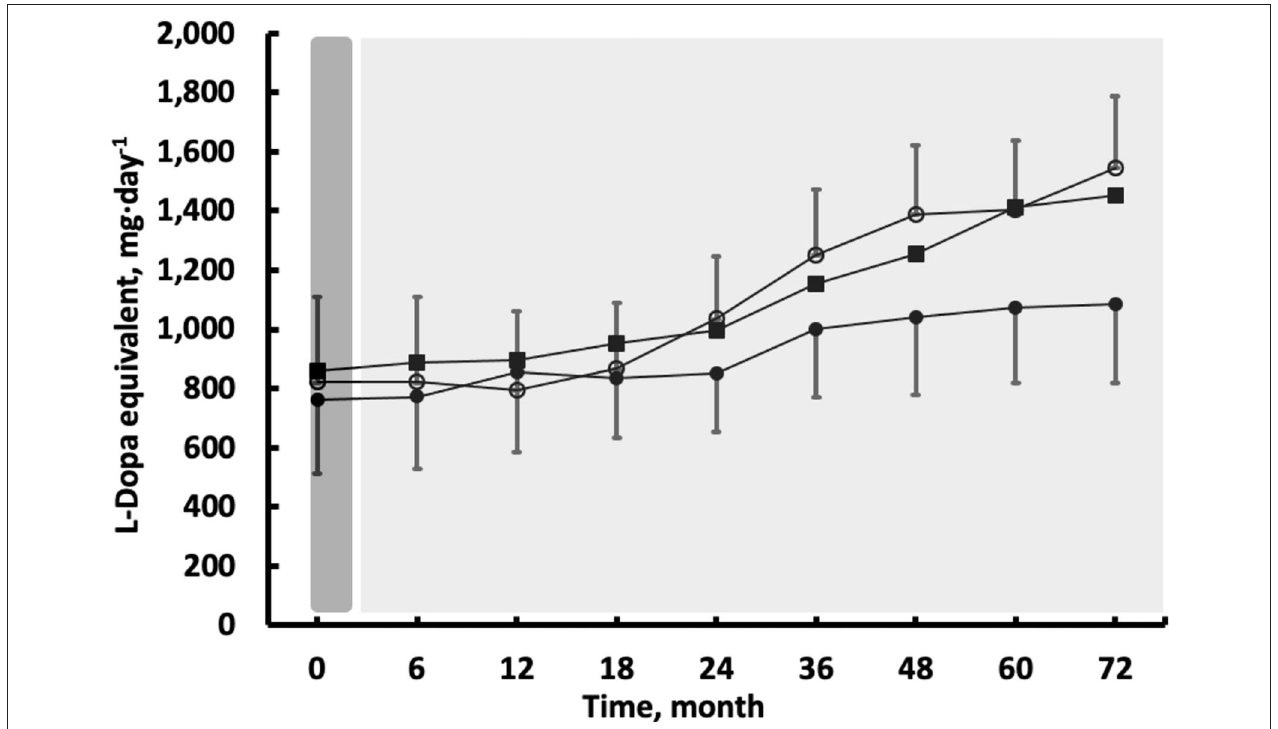
FIGURE 4 | The effects of 3 weeks of high-intensity Exergaming with (E + M, filled circles) and without (E, filled squares) subsequent maintenance Exergaming program, or no exercise and no maintenance control (C, open circles) on L-dopa equivalent dose. Compared with C, the drug dose was lower in E + M between months 24 and 72. Compared with E, the drug dose was lower in E + M between months 48 and 72 (all p < 0.05). The vertical bars denote ± 1 SD, omitted for clarity in the E group.